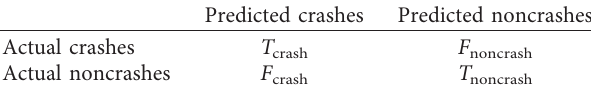
Table 2: Confusion matrix.